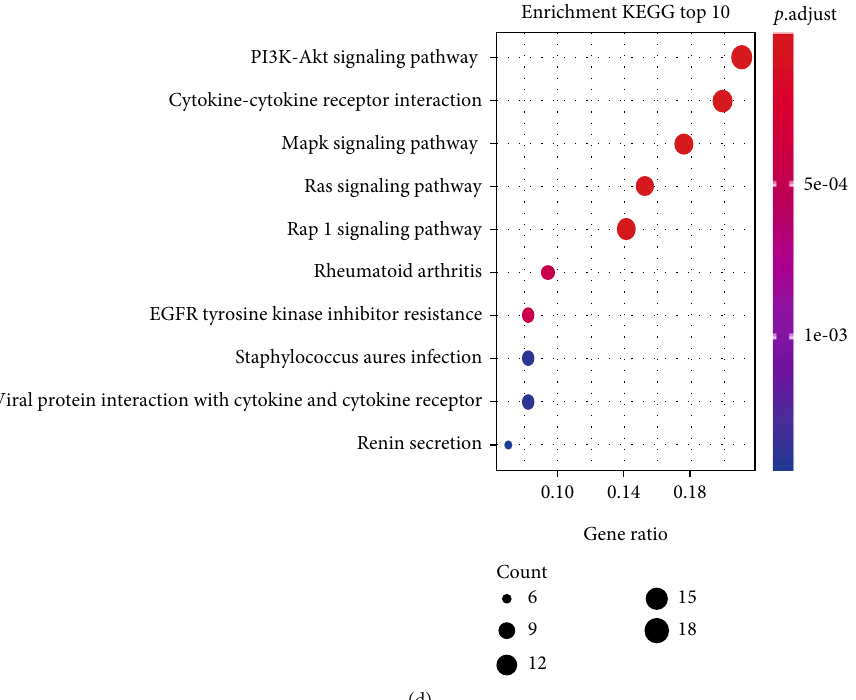
Figure 11: GO and KEGG pathway analyses of 94 DETFs and 111 DEIRGs in endometriosis. (a) The GO analysis of DETFs. (b) The KEGG analysis of DETFs. (c) The GO analysis of DEIRGs. (d) The KEGG analysis of DEIRGs. The GO analysis included the biological processes, cellular components, and molecular functions ( P < 0 : 05